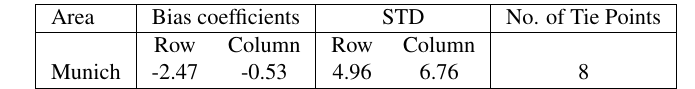
Table 3. The block adjustment